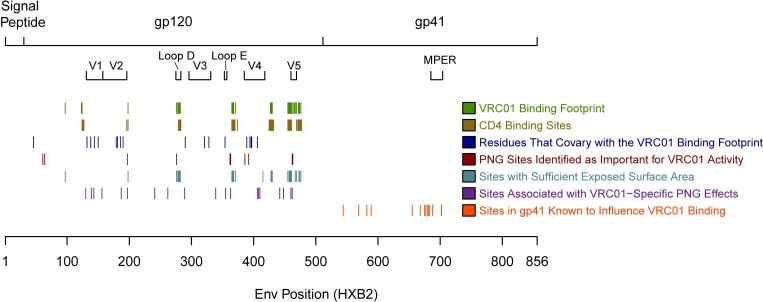
Specific sites in Feature Groups 1 to 7 before application of the minimum variability filter.